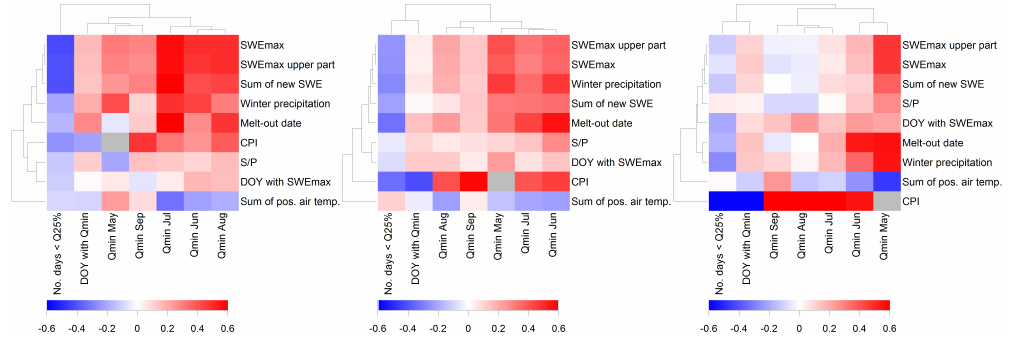
Figure 2. Heat maps showing Spearman rank correlation coefficients for all predictors (rows) and response variables (columns) separately for three elevation groups. Left panel: catchments with mean elevation higher than 2000ma.s.l.; middle panel: catchments with mean elevation between 1300 and 2000ma.s.l.; right panel: catchments with mean elevation between 850 and 1300ma.s.l. Hierarchical cluster analysis and Euclidean distance were used to show similarity of individual predictors and response variables. Grey colour used for NA